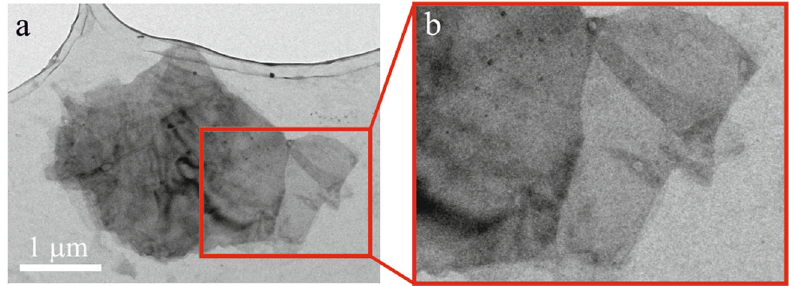
Fig. 5 TEM image of exfoliated few-layer sheets that appear almost transparent in the electron beam. a Flake obtained from swollen Bi 2 TeI crystals, which were heated in a mixture of PVP and IPA, and subsequently sonicated. b Detail in higher magni fi cation.